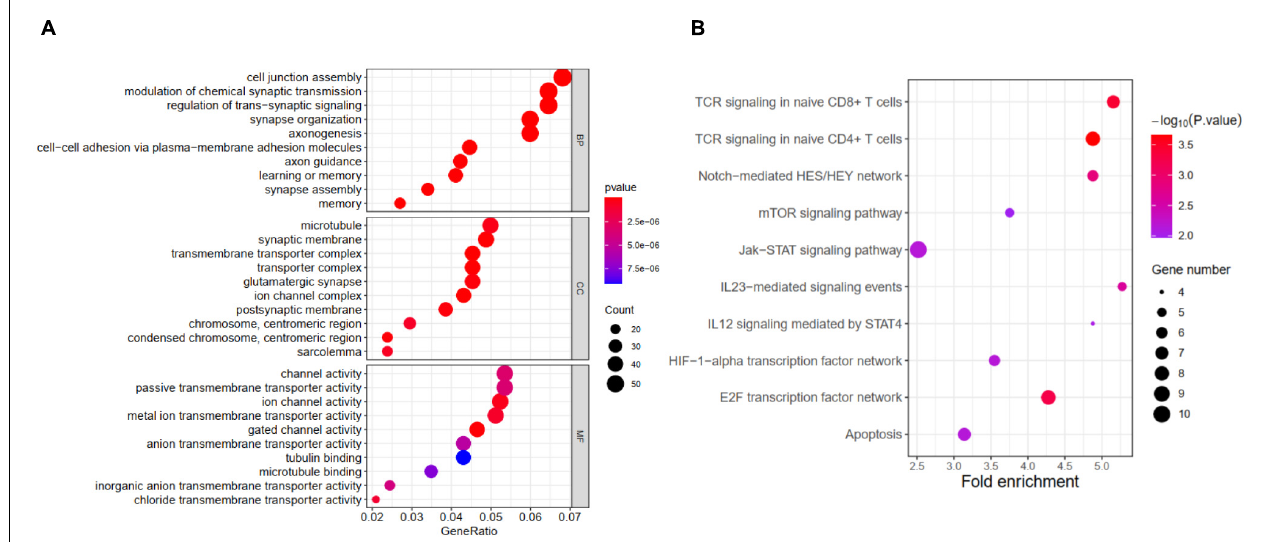
FIGURE 6 | Results of GSEA for ATG signature. (A) Significantly enriched GO terms by GSEA. (B) Significantly enriched pathways by